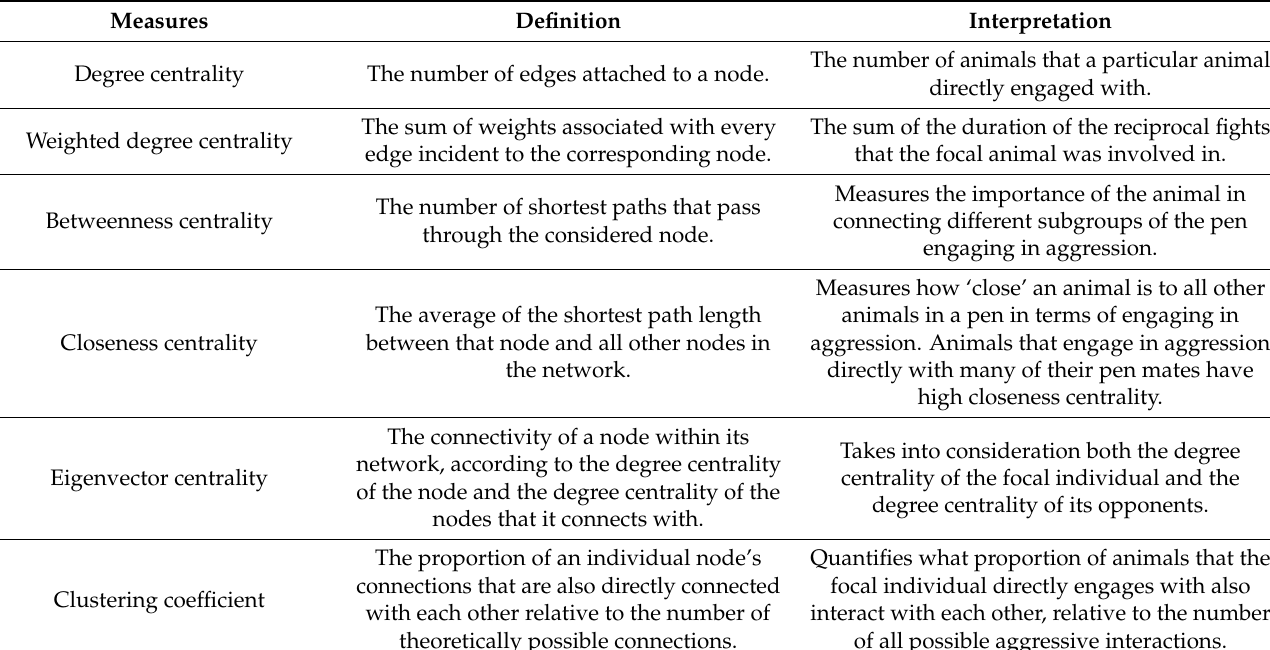
Table 1. Definition of the social network analysis traits considered in this